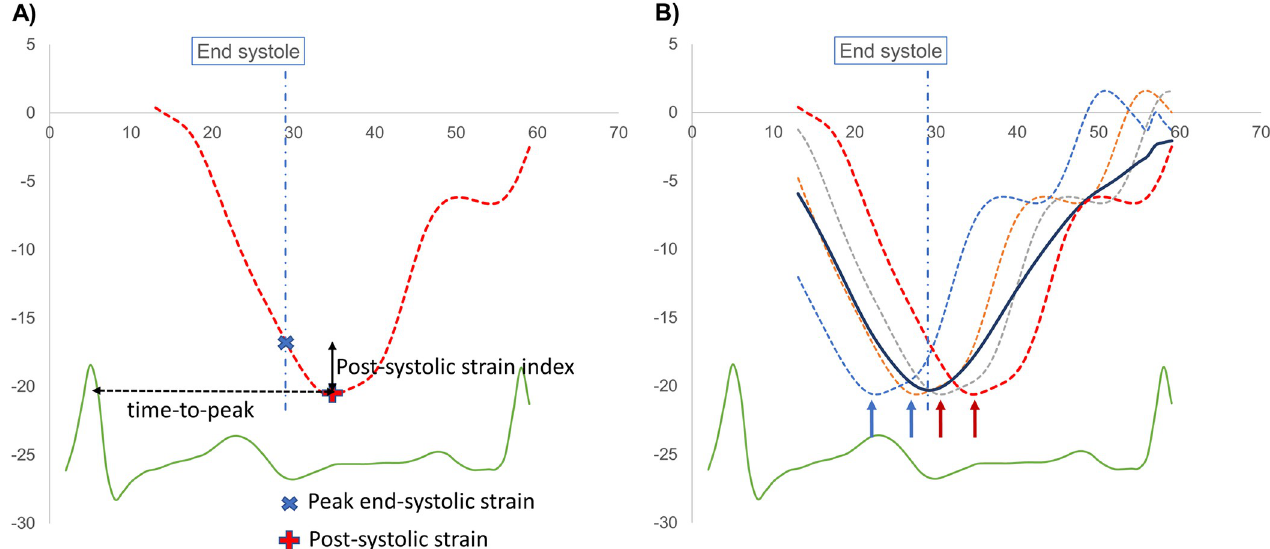
Fig 2. Schematic representation of Strain curves demonstrating (a) method of calculation of segmental post-systolic shortening index and time to peak strain and (b) relationship between global mechanical dispersion index and post systolic strain index. Panel A shows a single time-delayed segmental strain curve with values of peak end-systole strain (global) and maximum post-systolic strain marked by arrows. From these values, segmental post systolic strain index is calculated as: 100% × (maximum post-systolic strain–end-systole strain)/maximum post-systolic strain. If no regional post systolic strain present, its post- systolic strain index is 0. Time to peak interval, used to calculate mechanical dispersion index, and is represented by a broken arrow. Panel B shows four segmental strain curves dispersed in time and displayed as dashed lines, with their point-by-point average represented as a full black line. Two segmental strains peaking before end systole and having zero post systolic shortening are marked by blue arrows, while two segmental strains peaking after end systole and thus exhibiting post systolic shortening are marked by red arrows. Global post systolic shortening index is then calculated as the mean of segmental systolic shortening indices. Mechanical dispersion index is calculated as the standard deviation of segmental time-to-peak intervals. By default, absence of mechanical dispersion means absence of post-systolic shortening and vice versa.